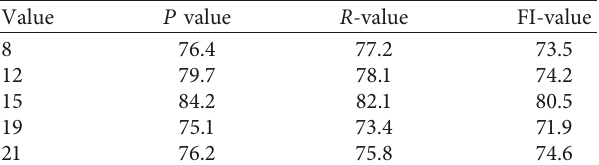
Table 2: Classification result.